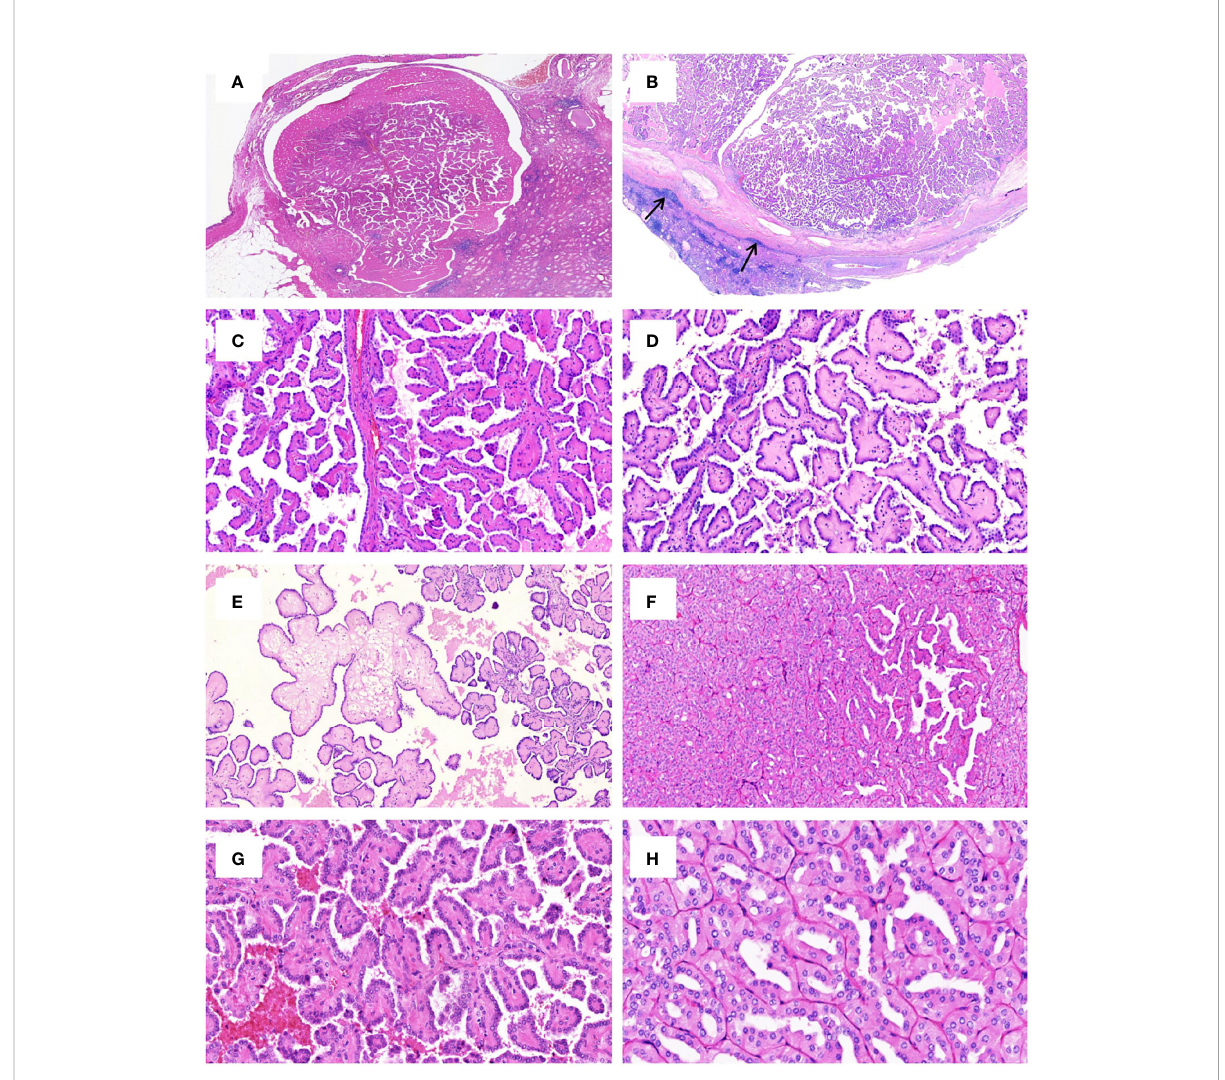
FIGURE 2 Histologic features of PRNRP. (A) Mixed solid and cystic tumor with eosinophilic proteinaceous material (HE, low magni fi cation). (B) Thick fi brous capsule with peri-capsule lymphoid cuff (arrows, HE, low magni fi cation). (C) Branching papillary architecture with delicate fi brovascular cores (HE, medium magni fi cation). (D) Hyalinized papillae (HE, medium magni fi cation). (E) Foci of edematous papillae (HE, medium magni fi cation). (F) PRNRP consisting mostly of solid, densely packed tubules with only a minor papillary component (HE, medium magni fi cation). The papillae ( G , HE, high magni fi cation) and tubules ( H , HE, high magni fi cation) are covered by oncocytic cells with inverted low-grade